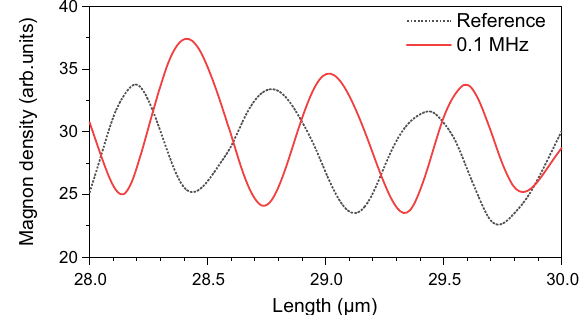
Fig. 4 Control of the azimuthal angle of the double magnon Bose – Einstein condensate (BEC). The black dotted curve represents the reference realization of the spatial distribution of the spontaneously formed double- BEC along the magnetization fi eld direction. The magnetic density is integrated along the y -axis perpendicular to the magnetization fi eld, see Fig. 1d. The solid red curve shows the change in this distribution when an external radio-frequency signal with a frequency of 0.1 MHz and an amplitude of 0.5 mT is applied to the structure of the dynamic magnon crystal during 50 ns. The shown spatial shift of the double-BEC's interference pattern by about a quarter of the BEC wavelength λ BEC corresponds to a change in the azimuthal angle φ of about π /2. . By having the possibility of controlled rotation in relation to the different axes of the Bloch ’ s (cid:6) 1 p 1 can sphere, the functionality of the Hadamard gate, H ¼ 1 ffiffi (cid:2) 1 1 2 be achieved.